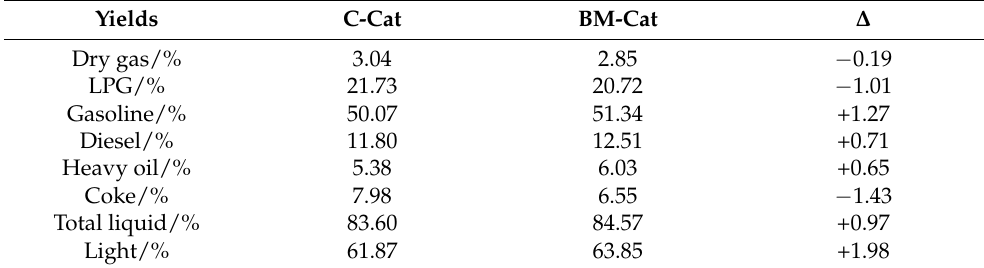
Table 4. Heavy oil catalytic cracking performances of fresh FCC